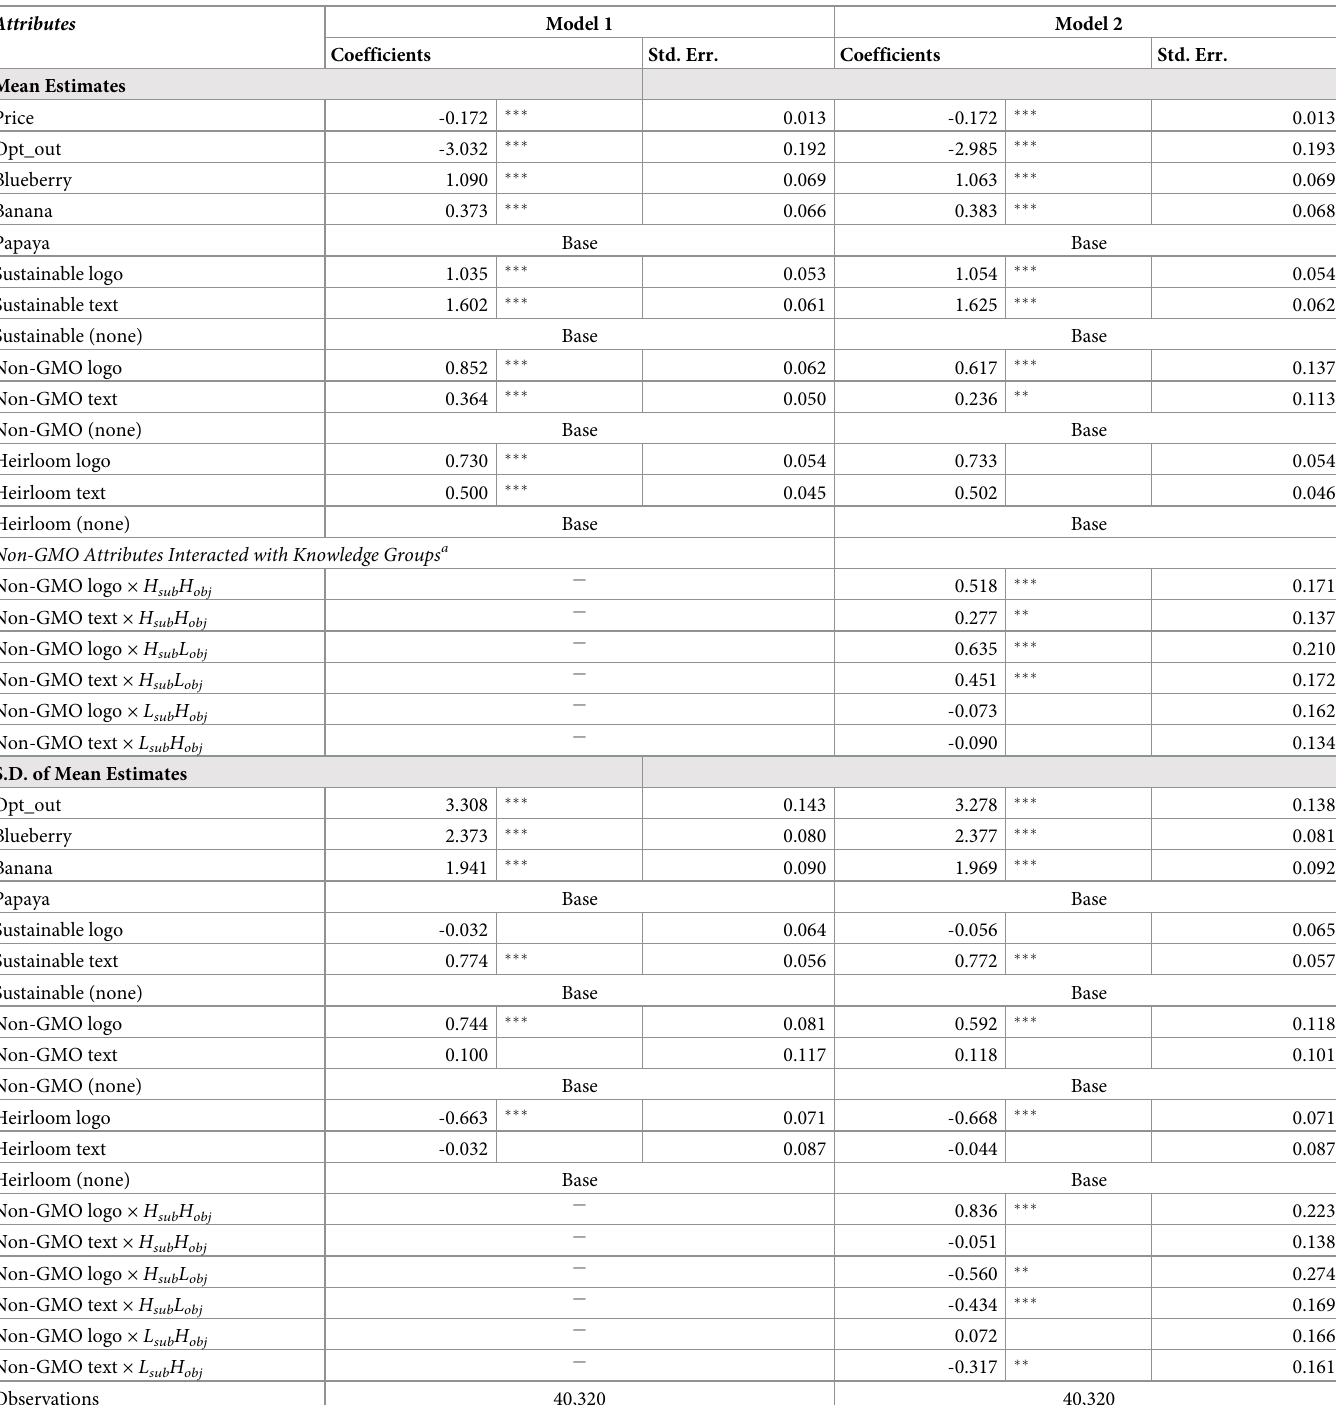
Table 3. Mixed logit estimates from an online choice experiment (n =